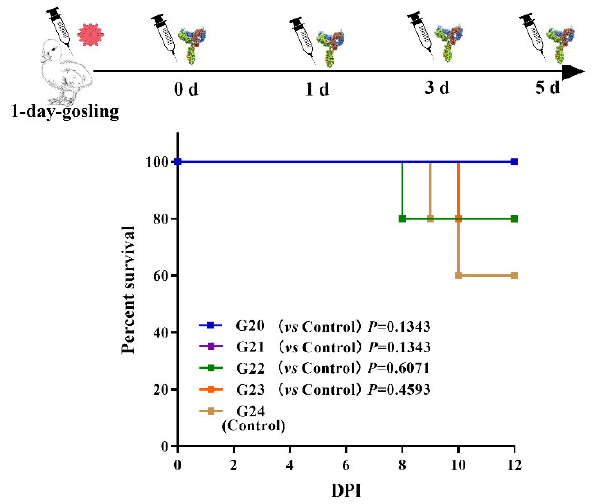
Figure 5. The survival rates of the G20–G24. G20–G24 were infected with GAstV at 10 5.84 TCID 50 subcutaneously on day 1. G20–G23 were inoculated with the anti-GAstV IgY at 0, 1, 3, and 5 dpi. G24 was a control group. The survival rates of G20–G24 were monitored daily. Data were analyzed by log-rank (Mantel–Cox) test. p values are expressed as mean ± SD, n = 5. ns p >